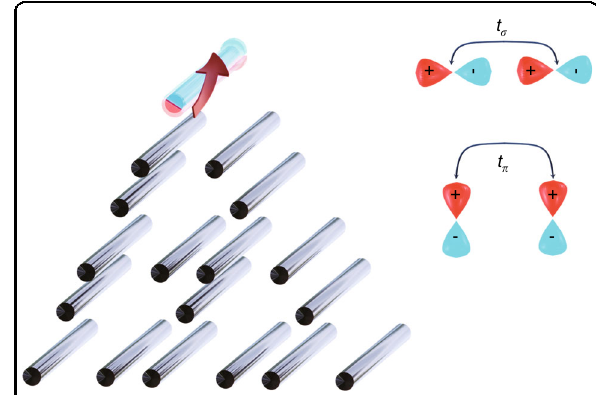
Fig. 1 Left panel shows a p-orbital corner state in a nontrivial BKL. Under a certain nonlinearity, a tilted diploe-like corner mode rotates towards a prefer direction while propagating forward. Right panel illustrates anisotropic couplings induced by the orbital degree of